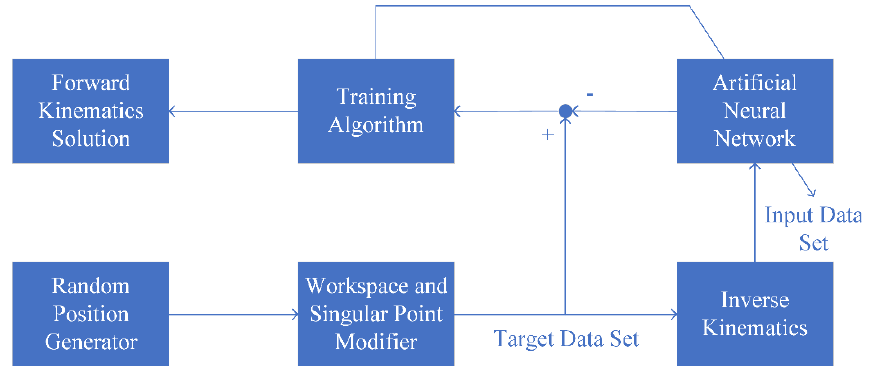
Figure 3. The procedure of neural network training [3].